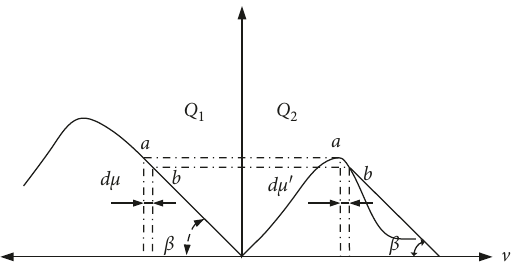
Figure 2: Line diagram of shear stress lateral